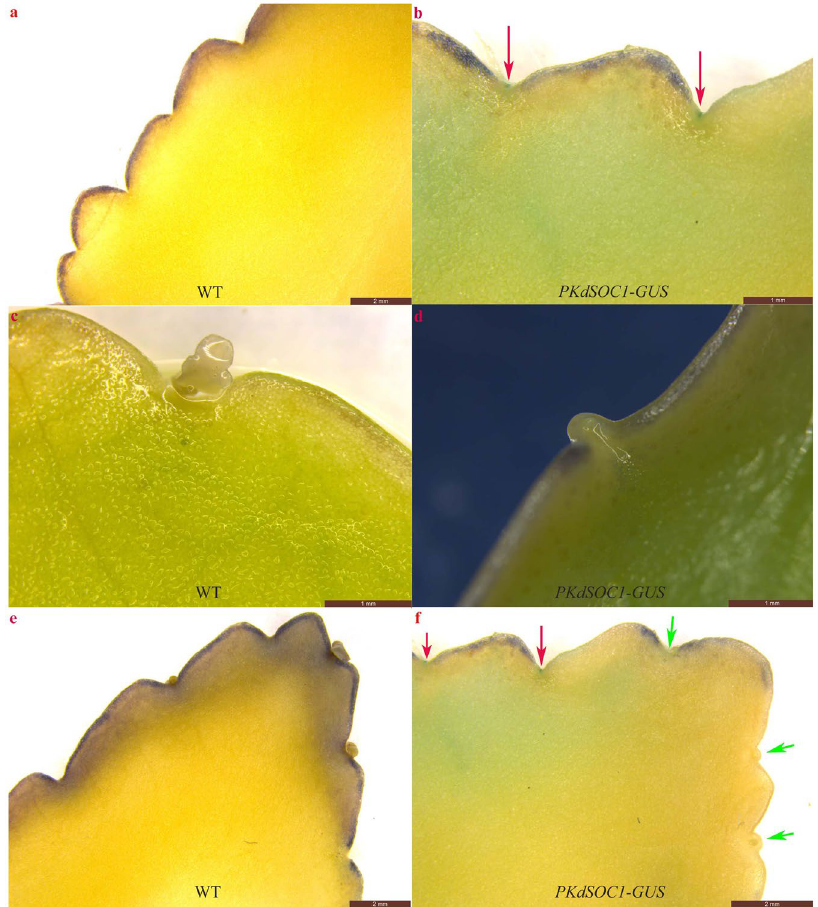
Figure 2. KdSOC1 gene expression profiles during Kalanchoe daigremontiana plantlet morphogenesis. ( a,b ) 14 days old leaves which only formed leaf serration. ( c,d ) 28 days old leaves which formed pedestal sites between each two leaf serration. ( e,f ) 37 days old leaves which formed plantlets along leaf